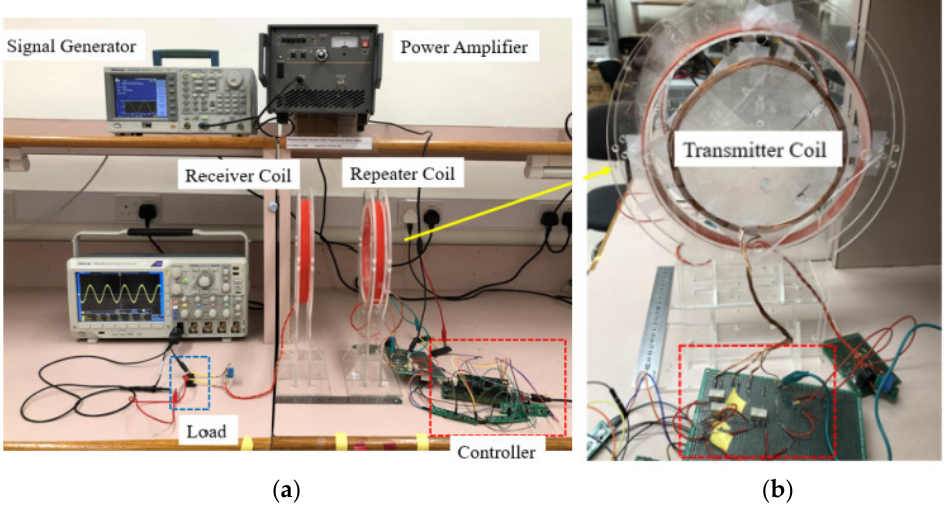
Figure 7. ( a ) Experimental setup and ( b ) prototype. Table 1. Parameters of the repeater coil and the receiver coil.